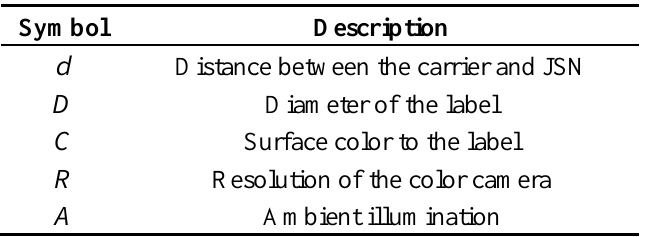
Table 1. The influence factors in the experimental